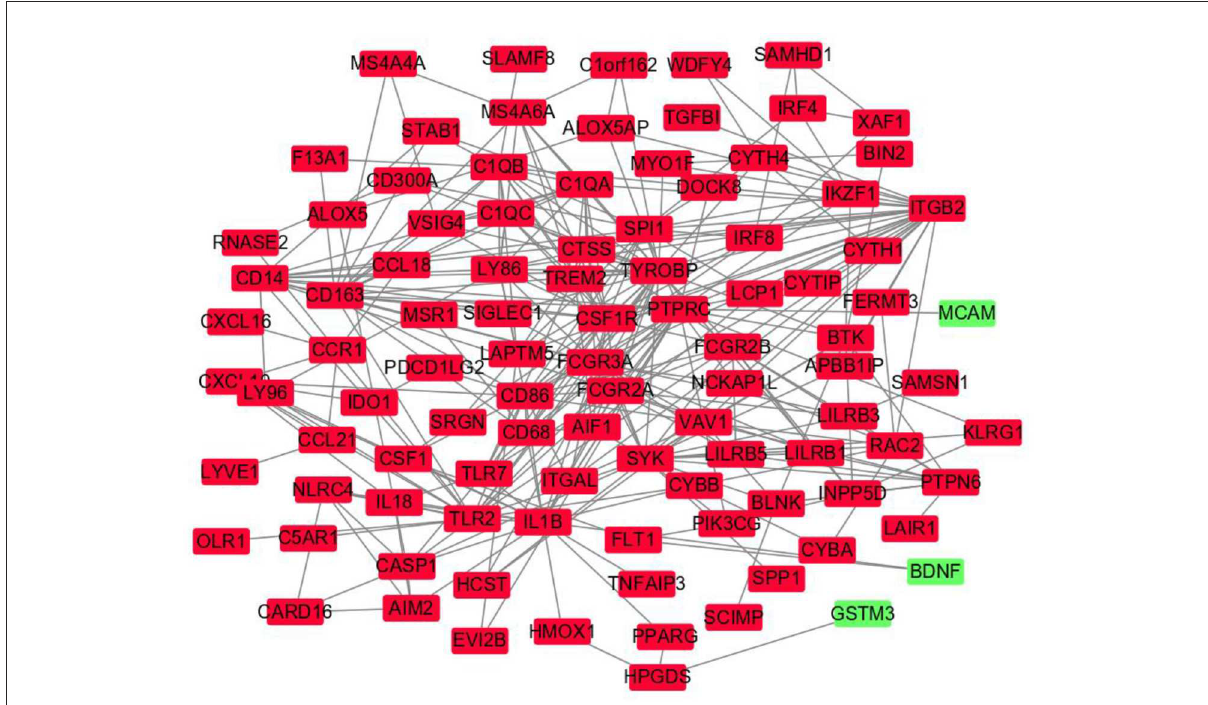
FIGURE3 Protein–protein interaction network constructed with the differentially expressed genes. Green nodes represent upregulated genes, and red nodes represent downregulated